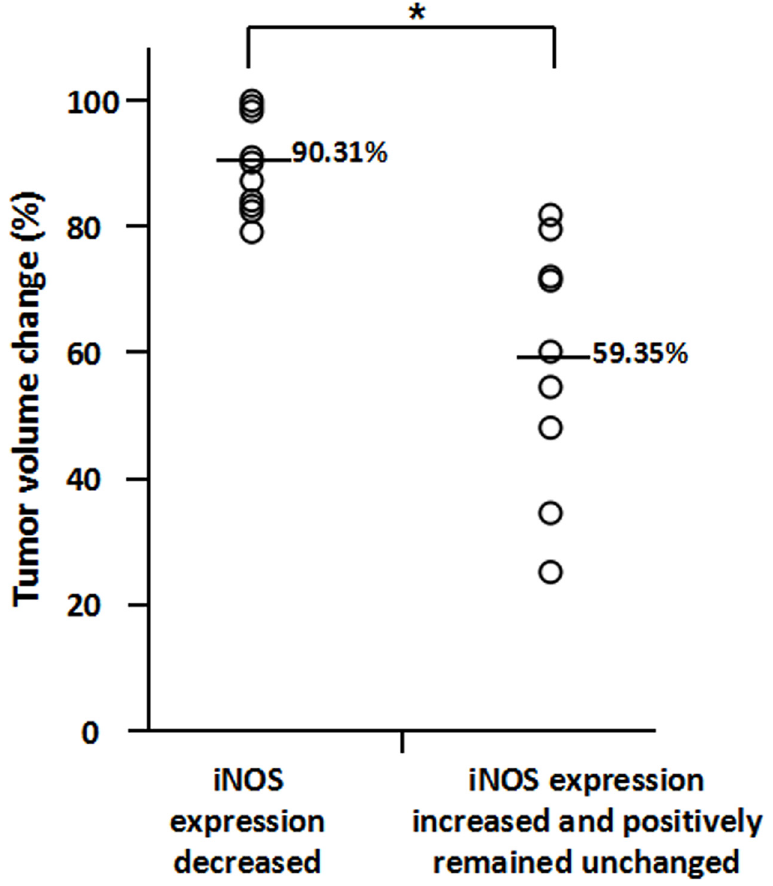
Fig 3. Comparison of tumor volume reduction in TNBC patients between iNOS expression decreased group and iNOS expression increased and positively remained unchanged group after neoadjuvant chemotherapy. Asterisk indicates p <